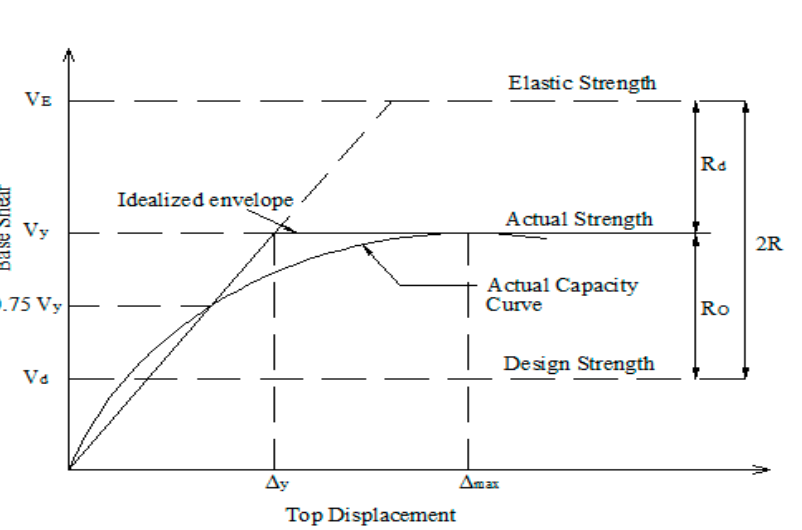
Figure 3. Interrelation between response reduction factor, over-strength, and ductility reduction factor [25].